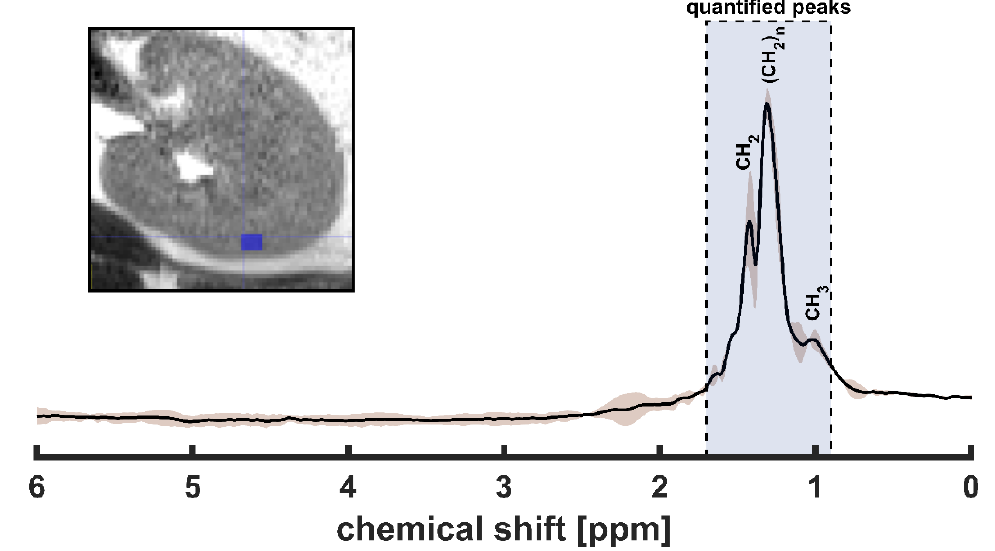
Figure 2. The spectral signature from the repeated scans within the kidney cortex. The image on the corner shows the region of interest (dark blue box) where the spectra were evaluated. The solid black line represents the mean signal, and the brown shade represents the standard deviation of the test–retest signal acquired from the same anatomical region. The blue shade highlights the peak’s bandwidth that has been covered to quantify the fat fraction. The labeled lipid peaks represent fatty acids of different saturation (CH 3 at 0.9 ppm, (CH 2 )n at 1.3 ppm, and CH 2 around 1.6 ppm).